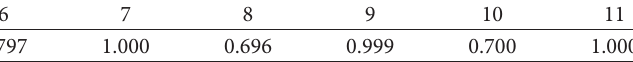
Table 3: Normalized informational entropy Δ for x